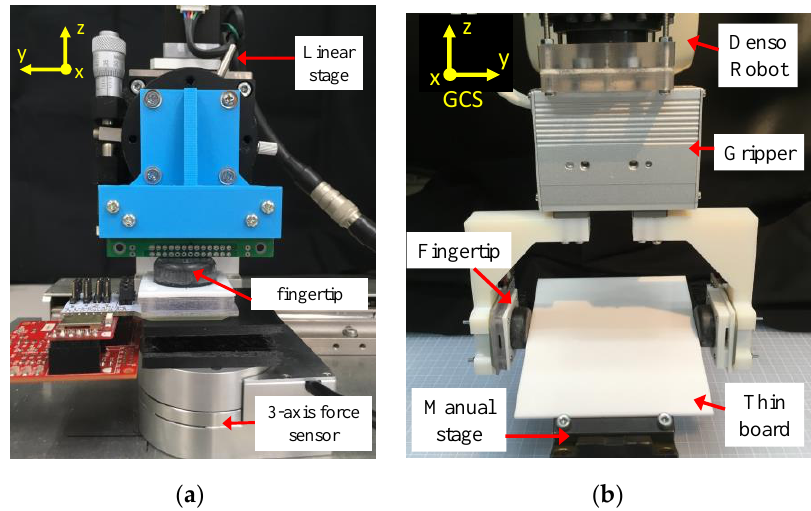
Figure 9. ( a ) Experimental setup for calibration process and ( b ) setup for grasping test.